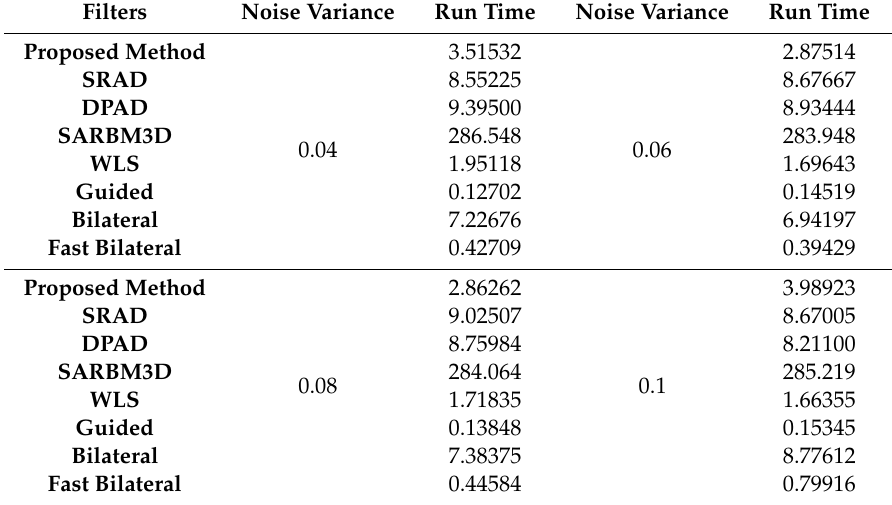
Table 17. Computational complexity results of the despeckling methods for the real SAR images 3 (600 × 418).